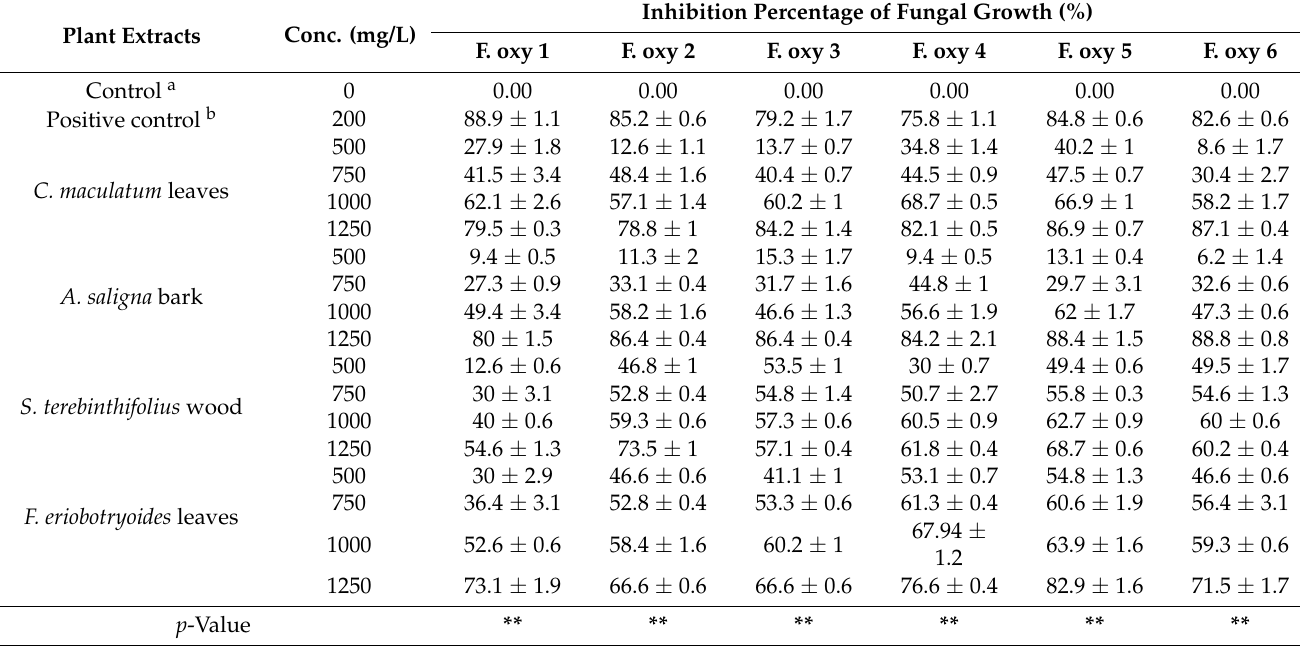
Table 2. Antifungal activity of plant extracts against six isolates of F. oxysporum . Plant Extracts